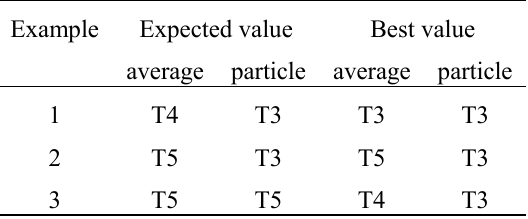
Table 7. Summary of the best trajectories for each case.